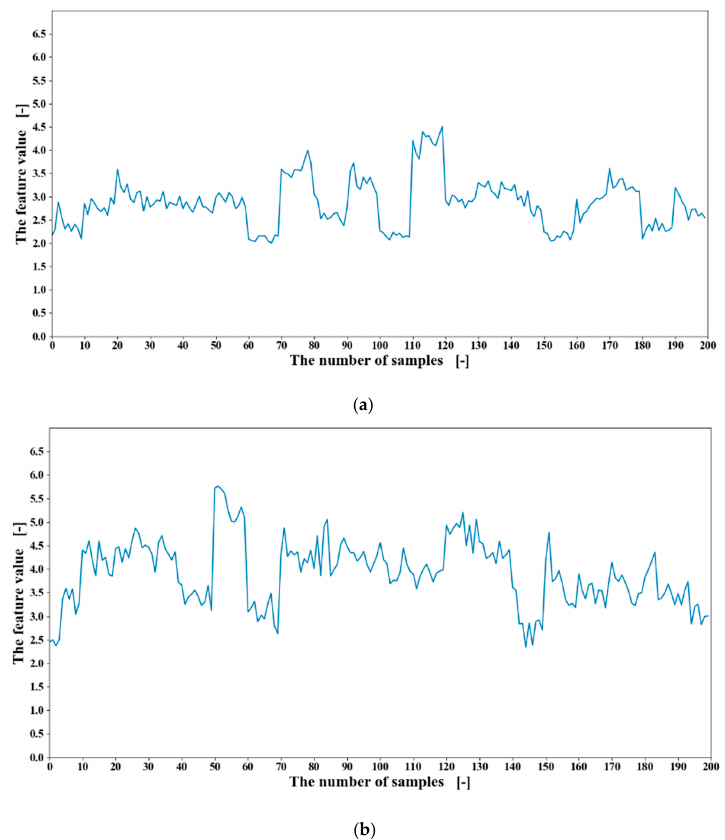
Figure 14. The RMS feature values of 20 motions from different participants:( a ) participant four; ( b ) participant five.